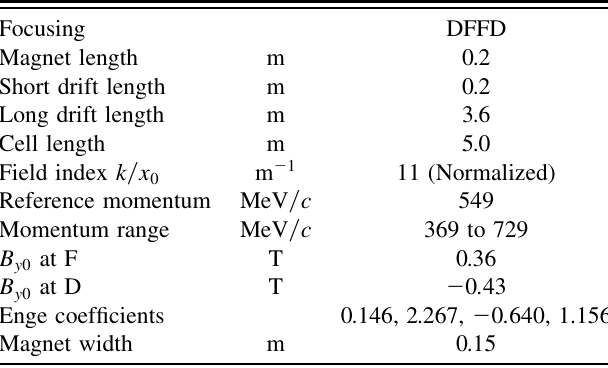
XXV. Parameters of DFFD cell for the